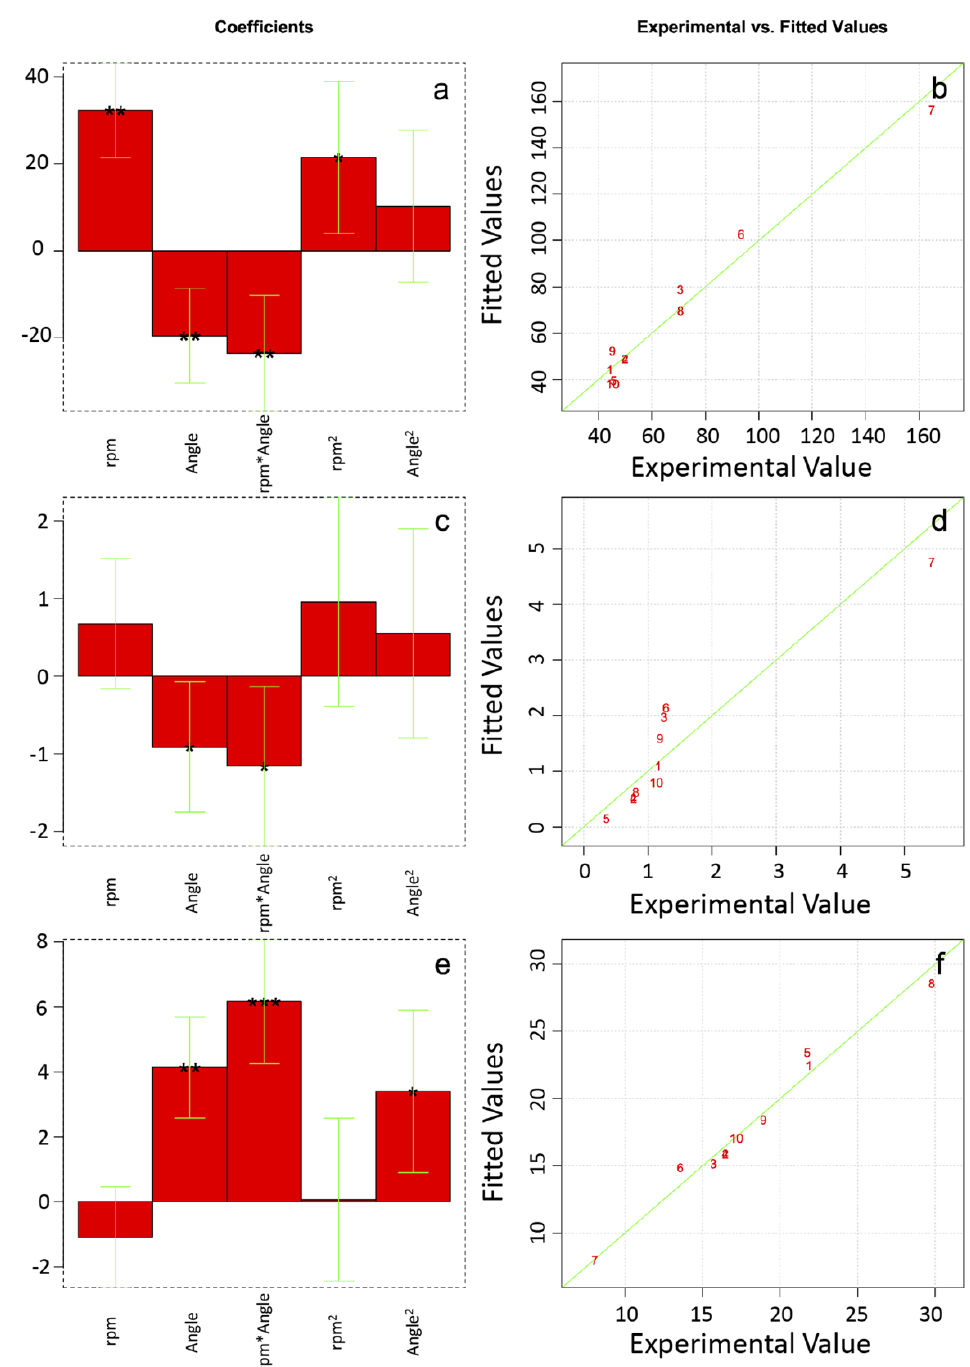
Figure 6. Model coefficients for the Young’s modulus ( a ), the maximum tensile strength ( c ), and the elongation at break ( e ); *** indicates a significance at p < 0.001, ** a significance at p < 0.01, and * a significance at p < 0.05. A comparison is shown between the experimental (numbers) and the theoretical (lines) values for the Young’s modulus ( b ), the maximum tensile strength ( d ), and the elongation at break ( f ).